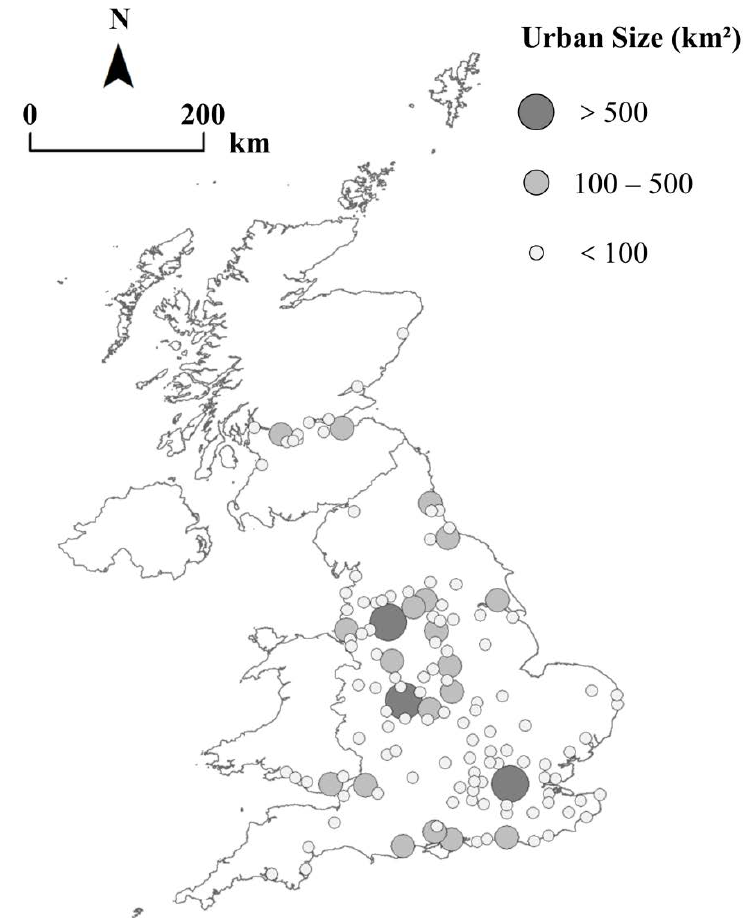
Figure 1. Locations of the 133 urban areas in Great Britain.